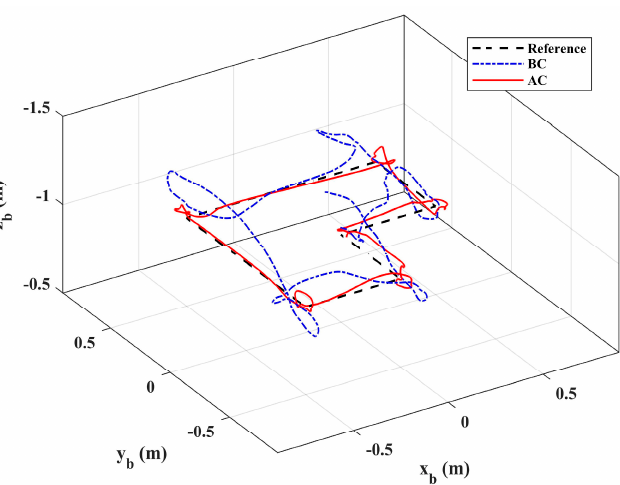
Figure 15. 3D trajectory in Scenario 2.